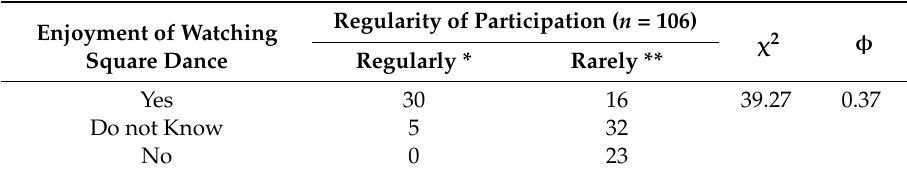
Table 12. Chi Squared Test comparing regularity of participation in Square Dance Activities to the enjoyment of watching square dance.